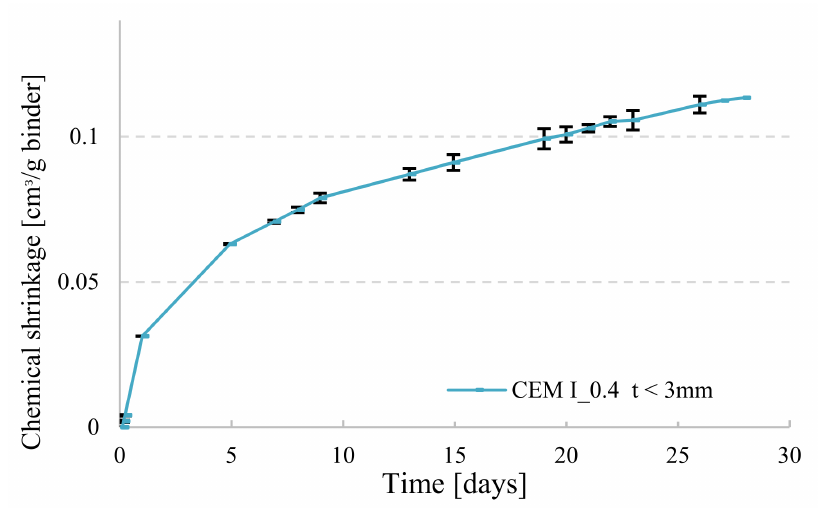
Figure 2. Representation of the repeatability of chemical shrinkage (CS) measurements (error bars represent the maximum and the minimum value taken from the sample